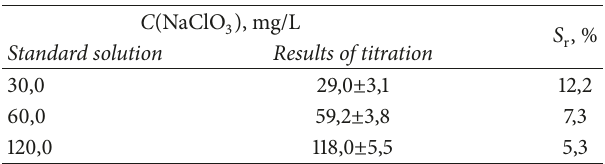
Table 1: Determination of sodium chlorate in the presence of potassium bromide (N = 5 is the number of titrations of the same sample and P = 0.95 is the confidence interval).